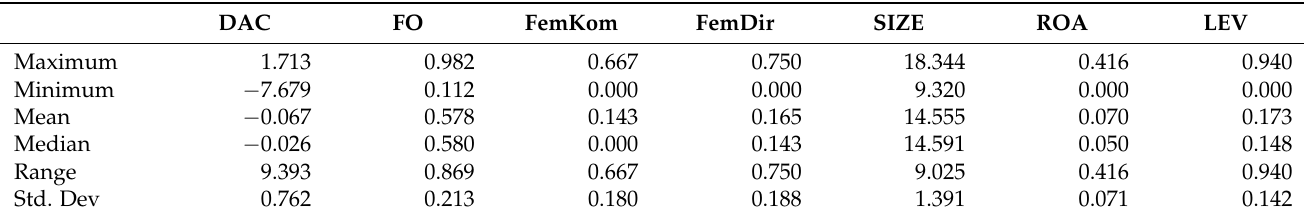
Table 2. Descriptive